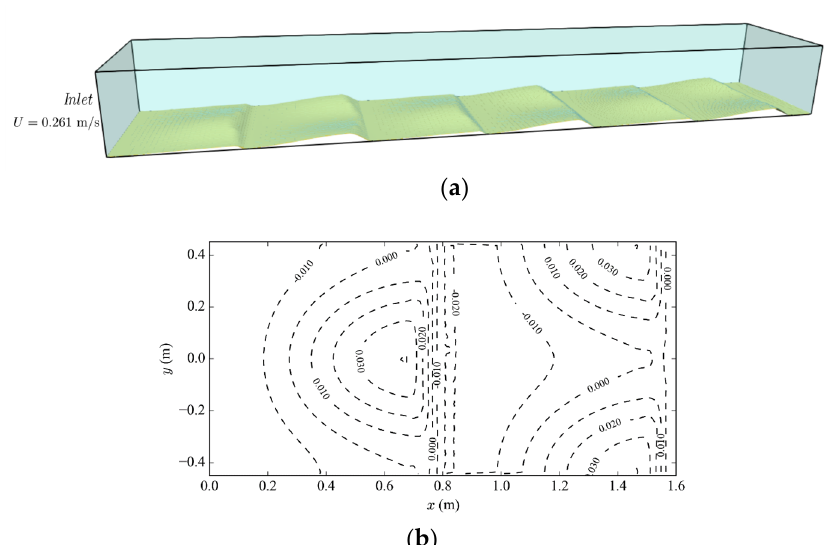
Figure 10. Simulation domain and bed boundary. ( a ) Sketch of the computational domain; ( b ) bed elevation of the 3D dunes in meters.